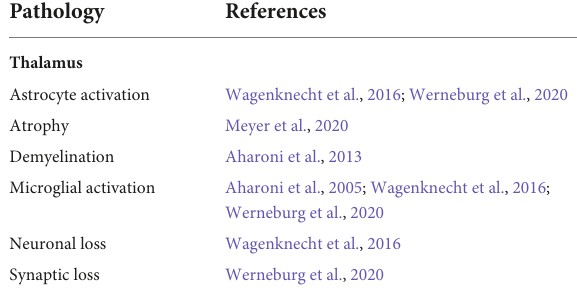
TABLE 2 Pathologies in the hippocampus in EAE. TABLE 3 Pathologies in the thalamus in EAE.